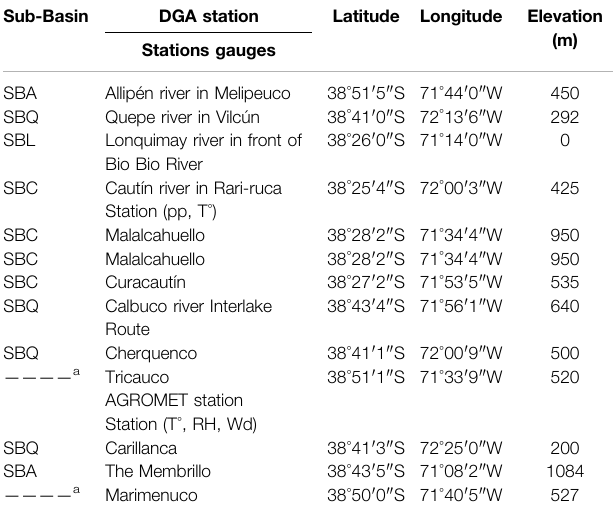
TABLE 1 | Land uses in the sub-basins Cautín river (SBC), Lonquimay river (SBL), Allipén river (SBA) and Quepe river (SBQ). Basin SBC